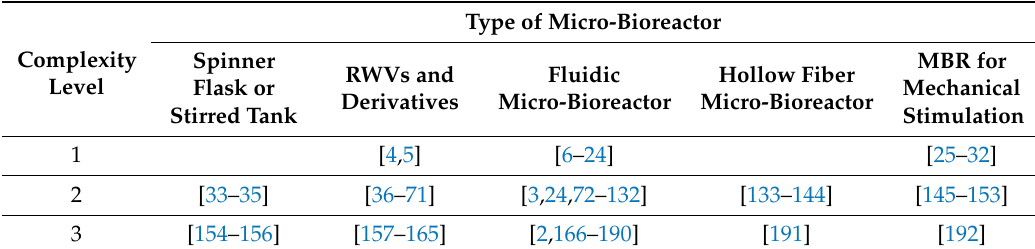
Table 1. List of the 192 publications used for the analysis, broken down by complexity level and type of